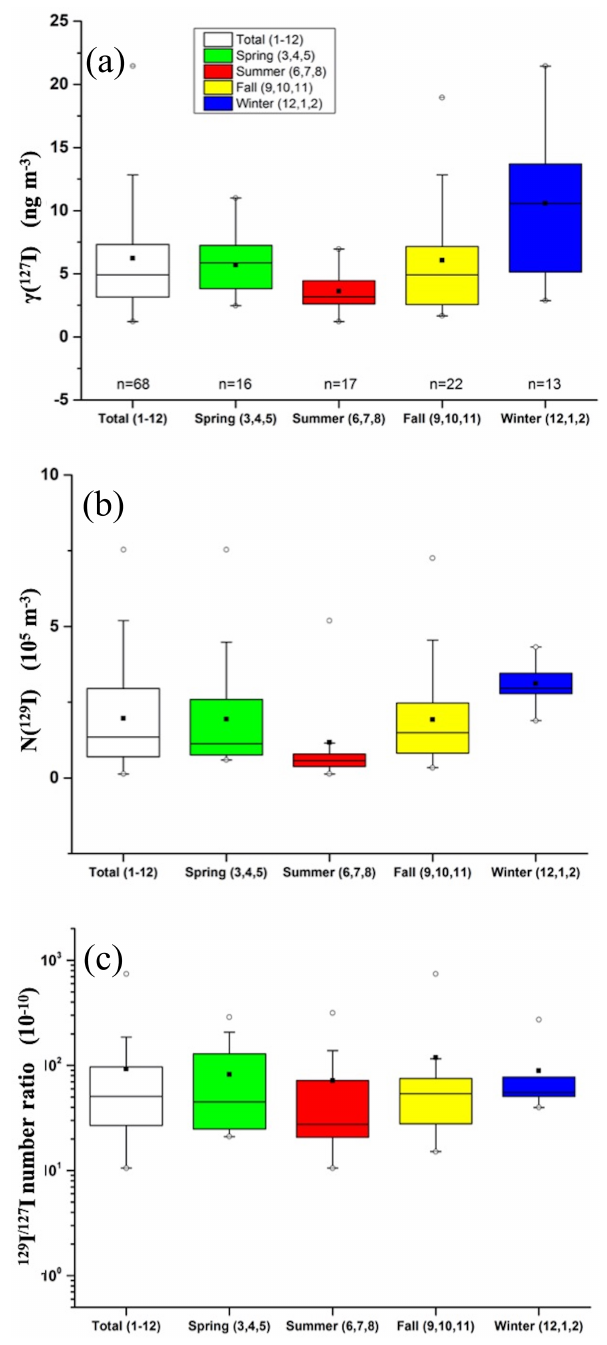
Figure 4. Seasonal variation in γ( 127 I ) (a) , N ( 129 I ) (b) and 129 I / 127 I number ratio (c) in aerosols collected in Xi’an, China, from March 2017 to March 2018. The boxes show the range from 25 % to 75 %. Mean and median values are indicated with black solid squares and horizontal bars, respectively. The whisker indi- cates the upper and lower limits excluding outliers shown by dots. The outliers are defined as those 1.5 times greater than the interquar- tile